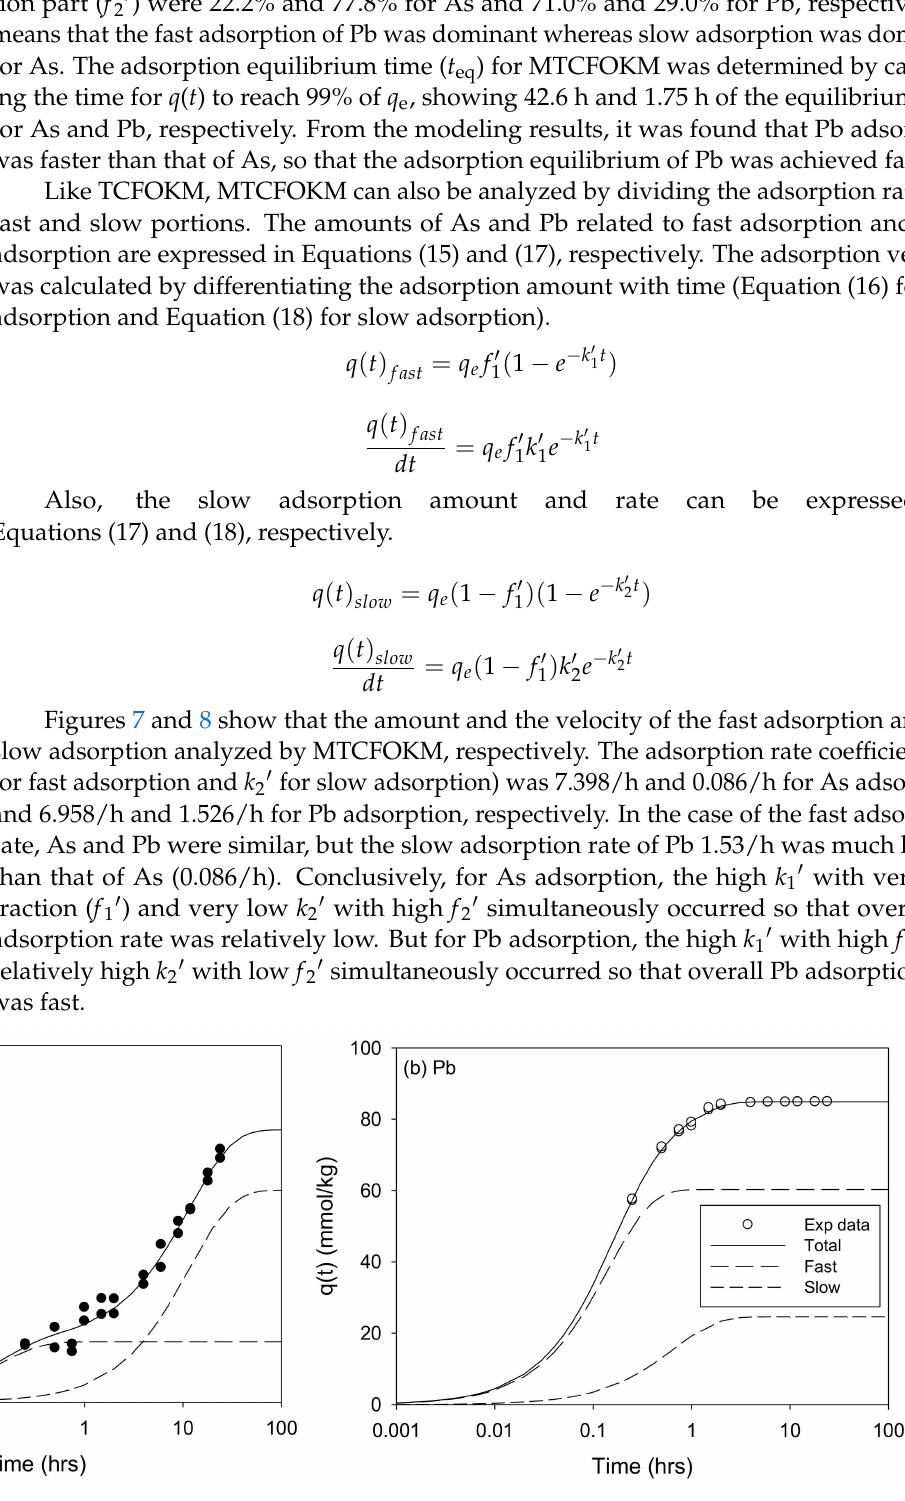
Figure 7. The amount of As and Pb of fast and slow adsorption by MTCFOKM with semi-log scale: ( a ) As and ( b )